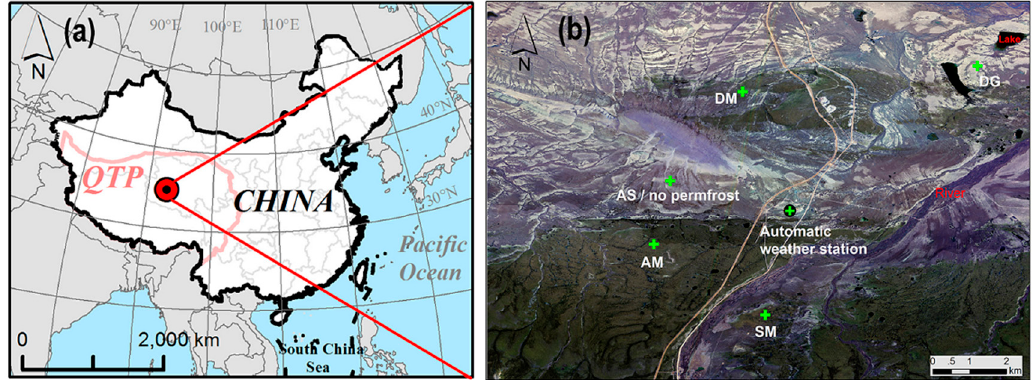
Figure 1. Location of the study area ( a ) and field sites on the QTP ( b ).